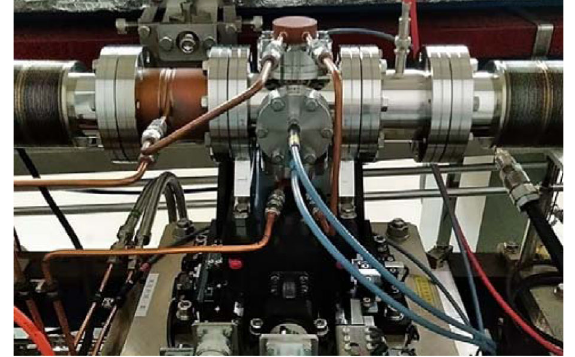
FIG. 16. Photograph of a pulse-mode XBPM installed in the SPring-8 BM-BL (BL02B1) front end. The monitor is mounted on a XY stage to be moved horizontally and vertically. The beam direction is from left to right.